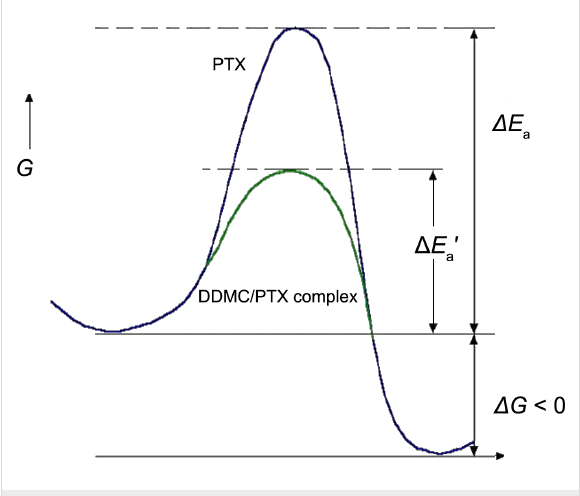
Figure 6: Potential energy curve of paclitaxel (large) and DDMC/PTX complex (small) in the tumor inhibition reaction. E a : activation energy of paclitaxel, E a ′ : activation energy of the DDMC/PTX complex. Reprinted from